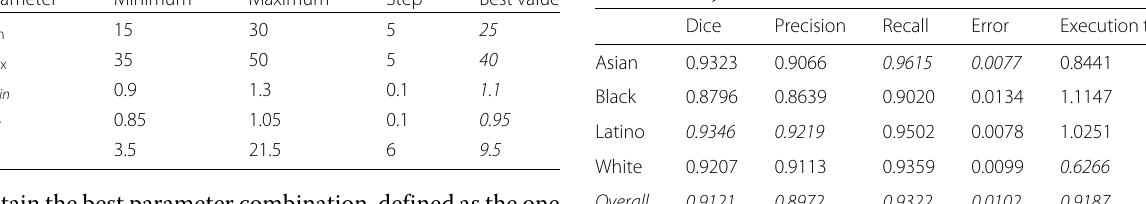
Table 3 Performance comparison of presented framework for each ethnicity Precision